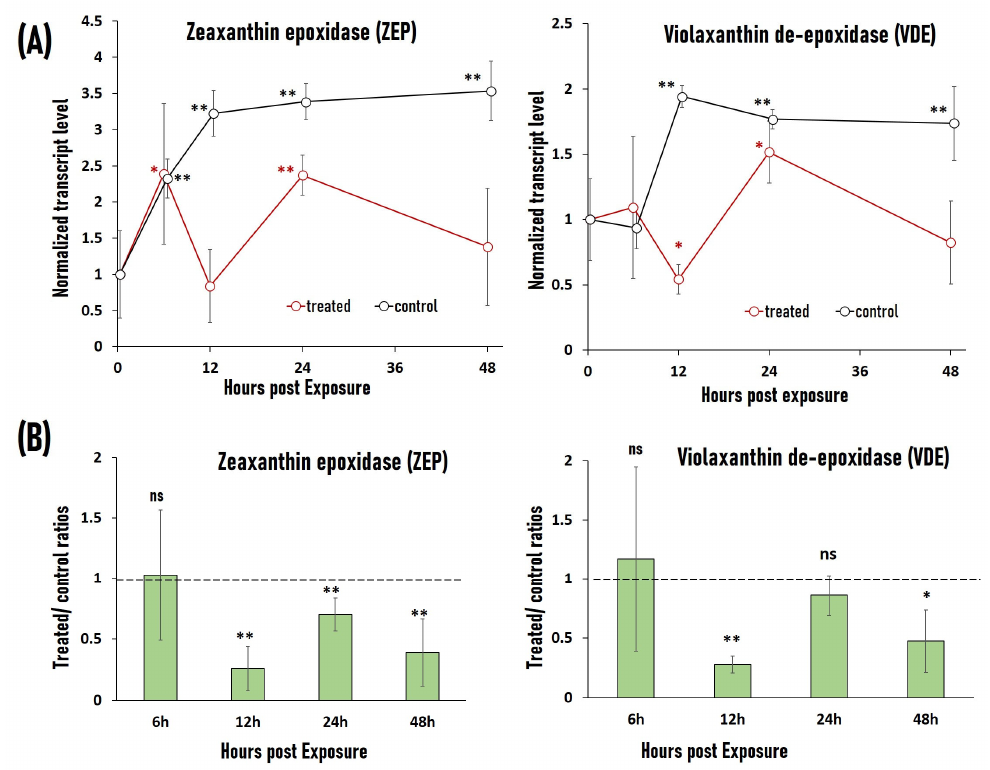
Figure 6. Gene expression analysis of stress genes violaxanthin de ‐ epoxidase (VDE) and zeaxanthin epoxidase (ZEP) in lettuce plants exposed to RF ‐ EMF. The reference gene is actin. ( A ) Normalized transcript levels of VDE and ZEP at 0, 6, 12, 24, and 48 h after RF ‐ EMF treatment. The average transcript levels of all plants at Time 0 (start of the RF ‐ EMF treatment) are determined as 1. Star symbols (*— 0.01 < p < 0.05; **— p < 0.01 ) denote the statistically significant differences to VDE/ZEP levels at t = 0 (threshold p = 0.05). Error bars represent 95% confidence interval (n = 3). ( B ) The treated/control ratio of VDE and ZEP transcript levels at 6, 12, 24, and 48 h after RF ‐ EMF treatment. Statistical symbols: ns—no statistically significant differences between control and exposed groups ( p > 0.05), *— statistically significant differences (0.01 < p < 0.05), **—statistically highly significant differences ( p < 0.01). Error bars represent 95% confidence interval (n = 3). Dotted line marks the position of treated/control ratio equal 1.